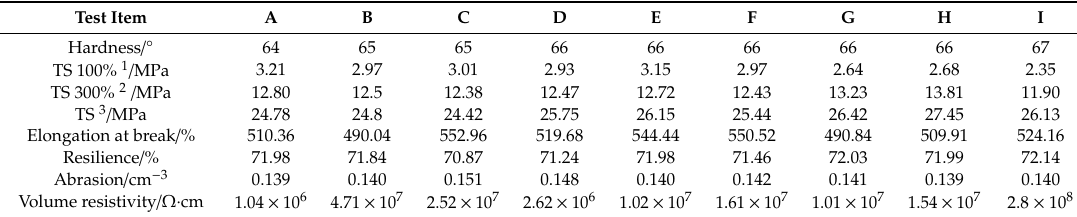
Table 4. The physical and mechanical properties of